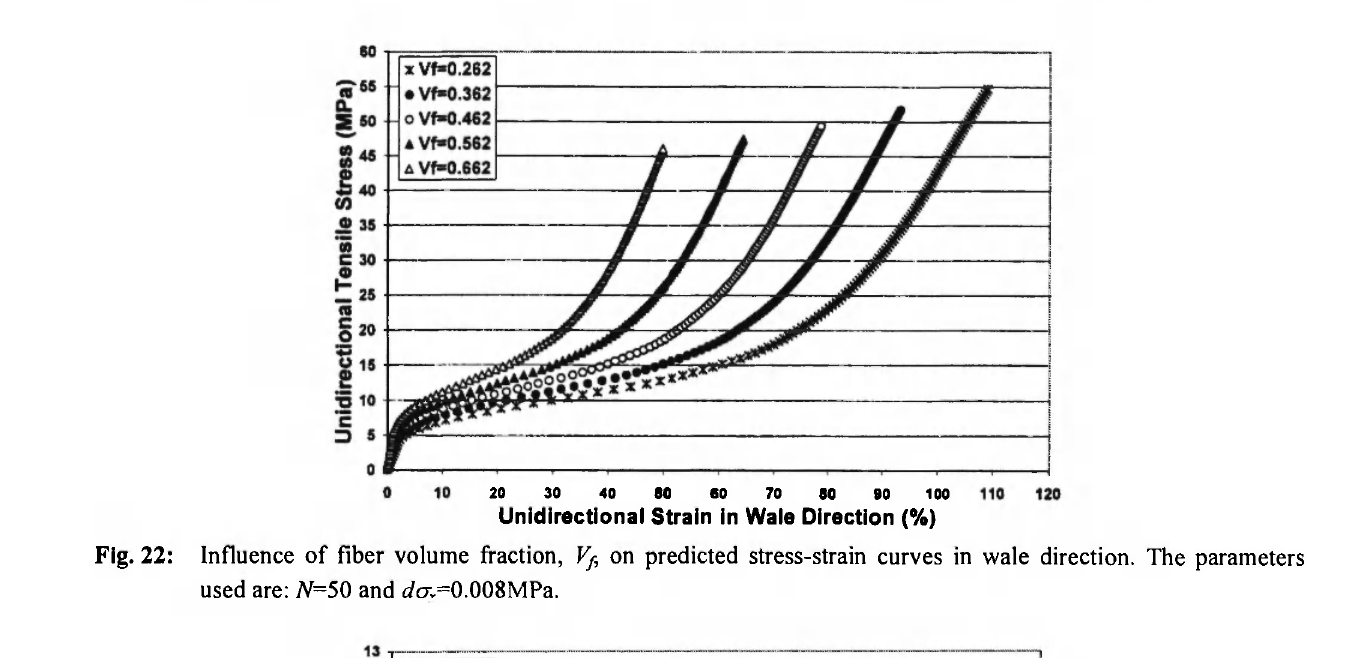
Fig. 22: Influence of fiber volume fraction, V fi on predicted stress-strain curves in wale direction. The parameters used are: N= 50 and ötov=0.008MPa.